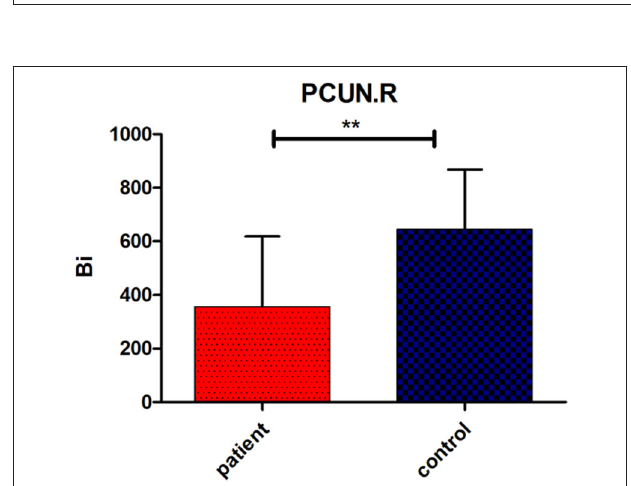
FIGURE 2 | Distribution of hubs in the cerebellar infarction group (A) and control group (B) . The hub nodes are shown in red, and node sizes represent their betweenness centrality values. For abbreviations of the hub regions, please see Table 2 .